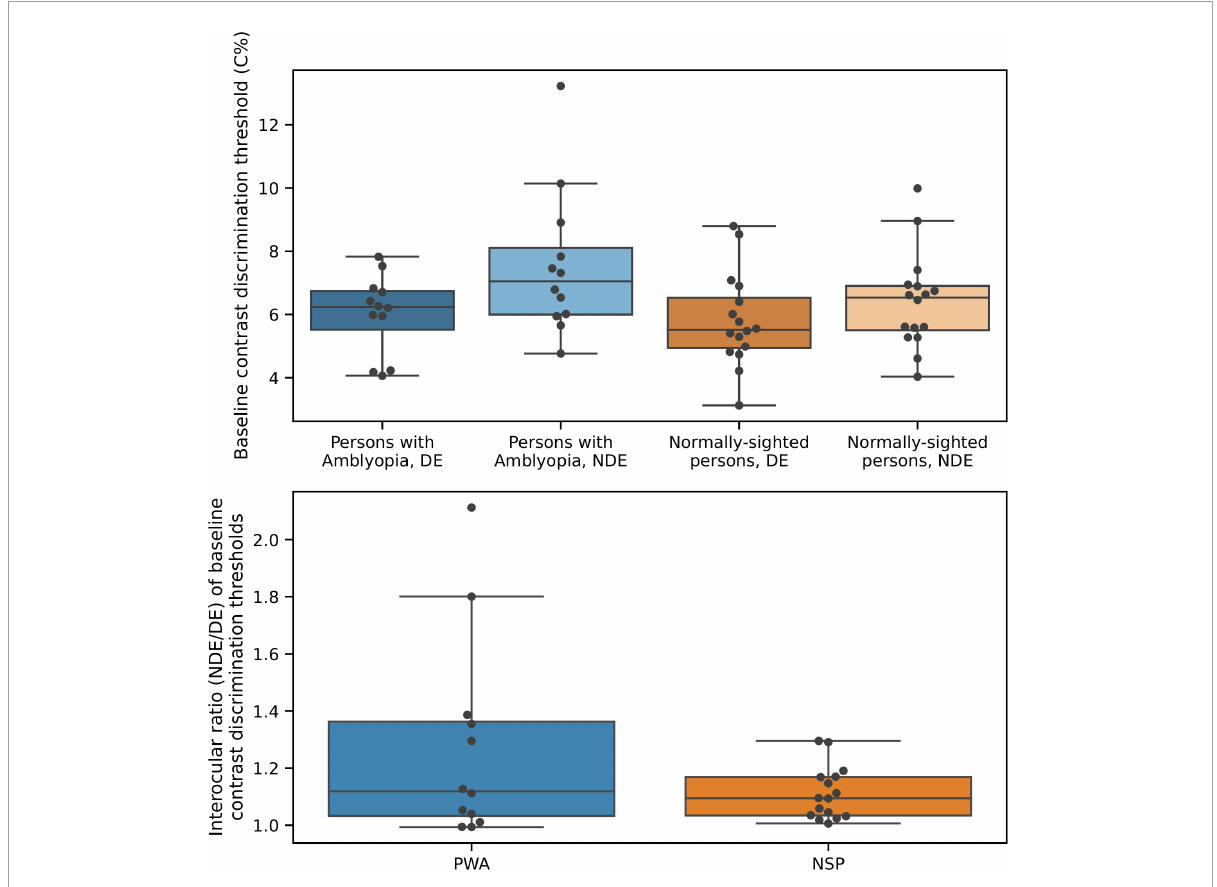
FIGURE8 Baseline contrast discrimination thresholds differ between the two eyes of persons with amblyopia. Top: Baseline contrast discrimination thresholds. Bottom: Interocular difference in baseline contrast discrimination thresholds.